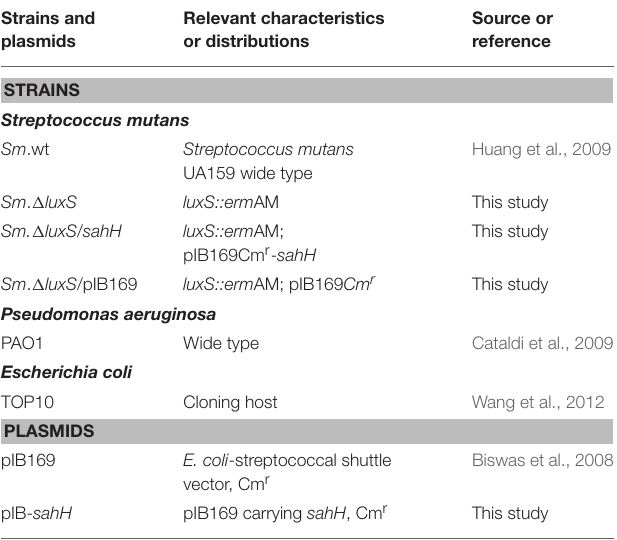
TABLE 1 | Strains and plasmids used in this